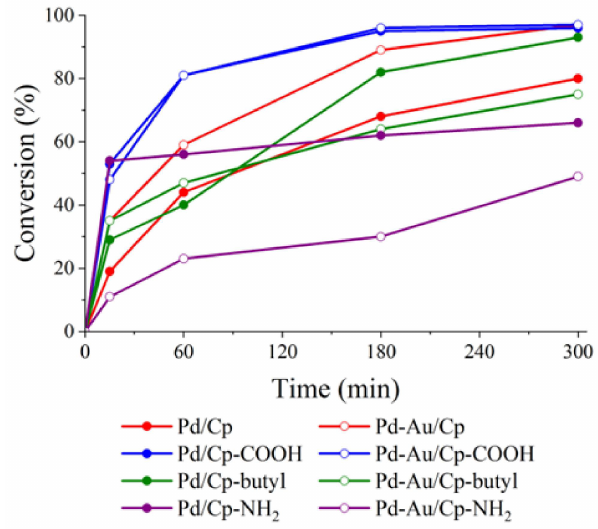
Figure 8. Conversion of furfural in hydrogenation processes over different catalysts. Reaction conditions: 0.3 M furfural (0.2882 g) in 10 mL 2-propanol, amount of catalyst 0.0645 g (Pd/furfural = 1:500 mol/mol; Pd-Au/furfural = 1:580 mol/mol), T = 50 ◦ C, p (H2) = 5 bar, t = 5 h, stirring 1000